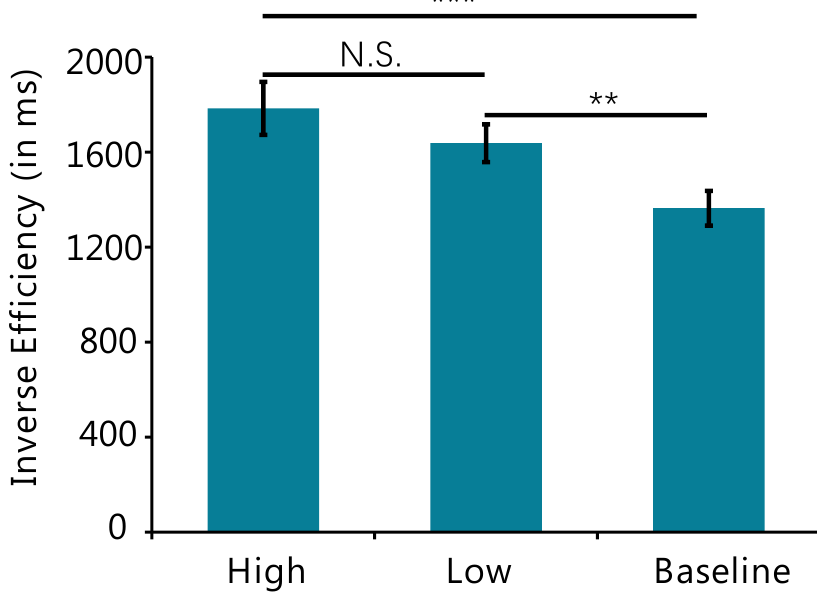
Figure 2. Inverse efficiency (by dividing the mean correct RTs by the proportion of correct responses) across conditions in Experiment 1. *** indicates p < 0.001; ** indicates 0.001 < p < 0.01; N.S. indicates p > 0.1.